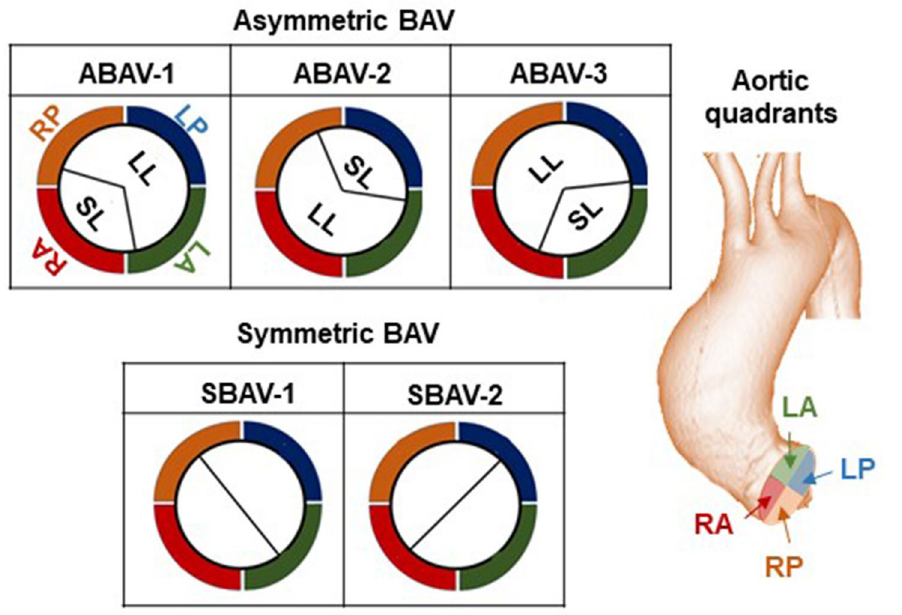
Figure 2. A classification scheme for bicuspid aortic valve (BAV) morphology based on the symmetry and position of the leaflets. Asymmetric BAVs (ABAVs), with two cusp angles of 240°–120°, includes ABAV-1, ABAV-2, and ABAV-3 morphologies. Symmetric BAVs, with two cusp angles of 180°–180°, includes SBAV-1 and SBAV-2 morphologies. The spatial positions of the leaflets are defined based on the aortic quadrant that the leaflets face. LA left-anterior quadrant of the ascending aorta, LP left-posterior quadrant of the ascending aorta, RA right-anterior quadrant of the ascending aorta, RP right-posterior quadrant of the ascending aorta, LL larger leaflet, SL smaller